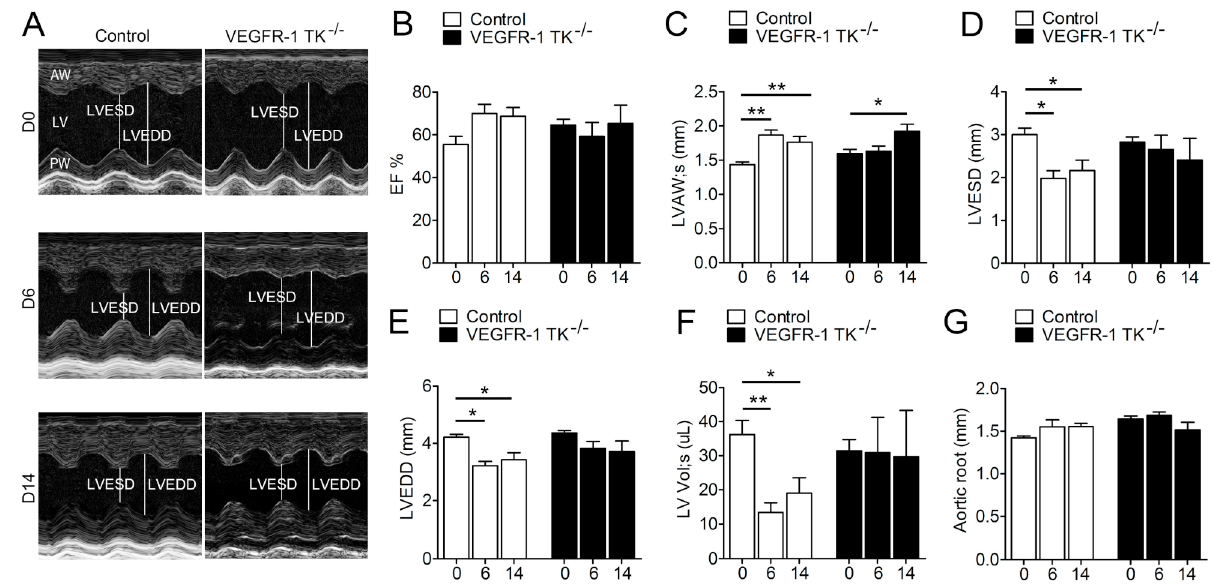
Figure 1. VEGFR-1 signaling regulates the early stage of compensatory LVH. Progression of LVH as followed by echocardio- graphy. ( A ) Representative short axis view images of LVs at day 0, 6 and 14. ( B ) LV ejection fraction (EF; n = 6–13/group). ( C ) LV anterior wall (LVAW) thickness (n = 6–13/group). ( D ). LV end-systolic diameter (LVESD; n = 6–13/group). ( E ) LV end-diastolic diameter (LVEDD; n = 6–13/group). ( F ) LV systolic volume (LV Vol;s; n = 6–13/group). ( G ) Aortic root diameter (n = 6–13/group). Values are mean ± SEM. Statistical analyses were performed using one-way ANOVA with Bonferroni’s post hoc test. *** p < 0.001; ** p < 0.01; * p <